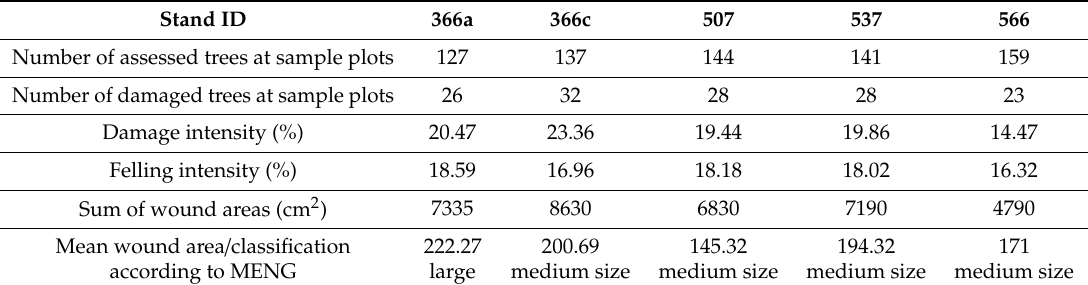
Table 6. Overview of stand damage results in individual forest